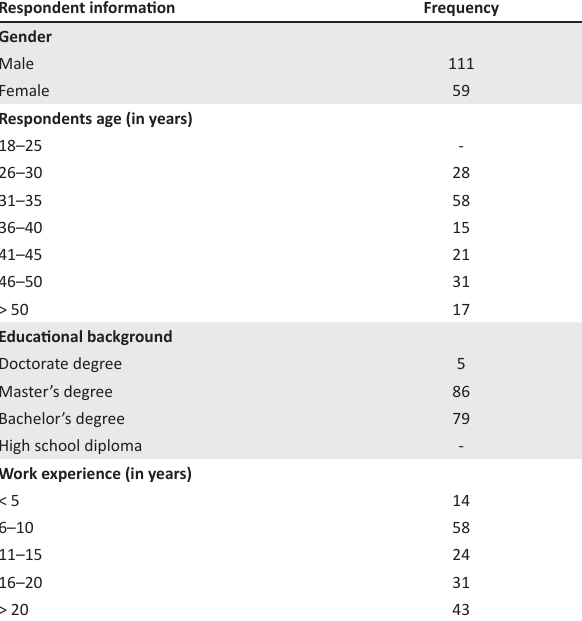
TABLE 1: Profile of respondents. TABLE 2: Descriptive